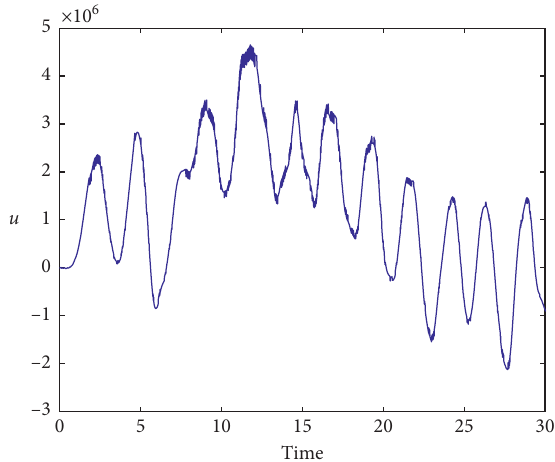
Figure 3: Variation of control parameter u for Figure